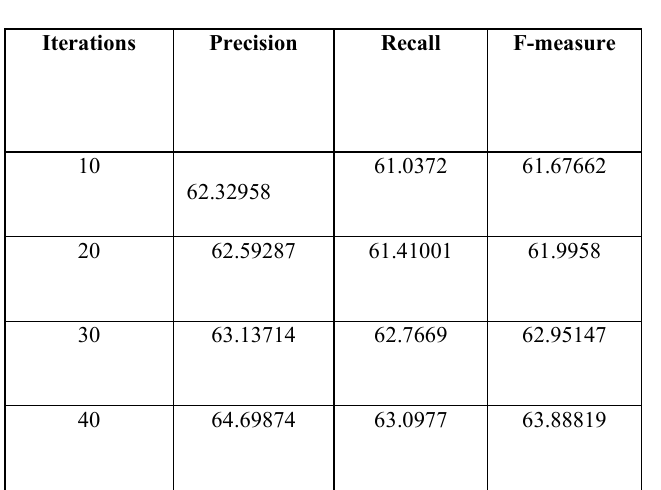
Table 3. Precision, Recall and F-Measure values for existing Cuckoo technique.